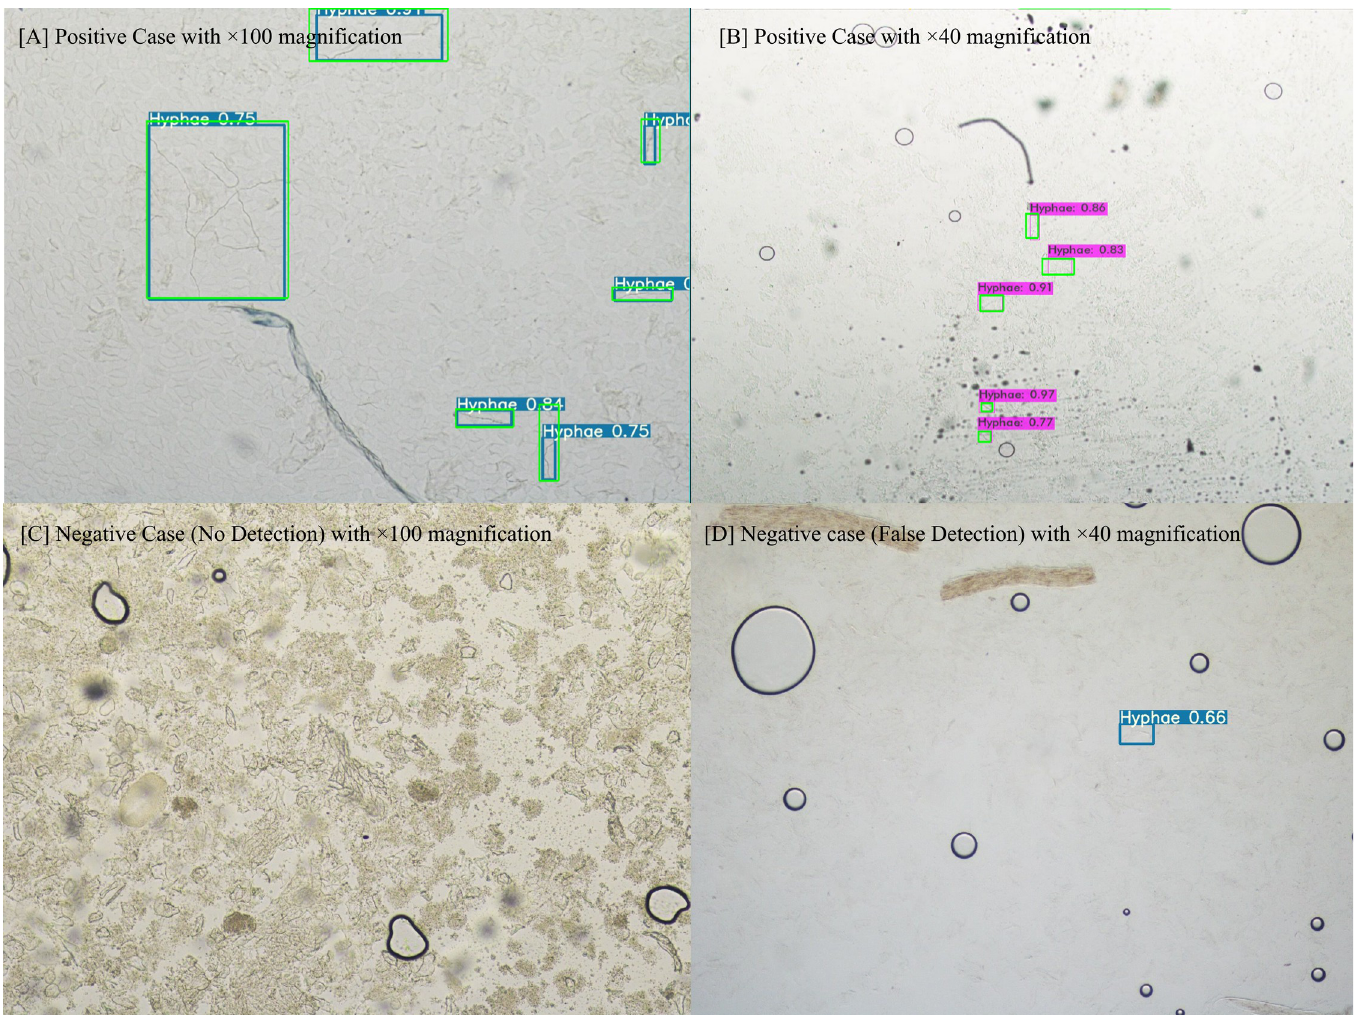
Fig 3. Example images of the autodetection of hyphae with bounding box. ¥ (A) positive case with 100 × magnification, (B) positive case with 40 × magnification, (C) negative case with 100 × magnification, and (D) negative case (false detection) with 40 × magnification. ¥ The ground truth were marked with a green box in positive case (A, B).